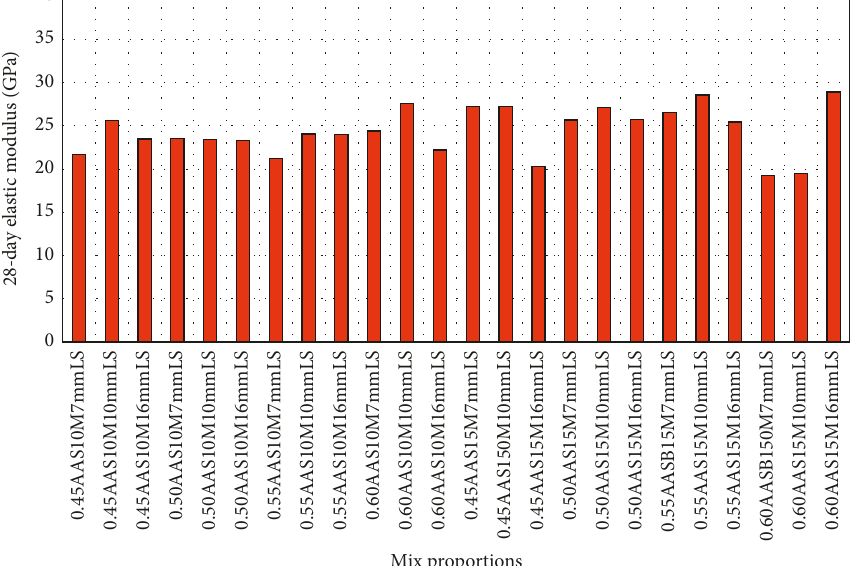
Figure 9: 28-day elastic modulus of the AAHFAC.